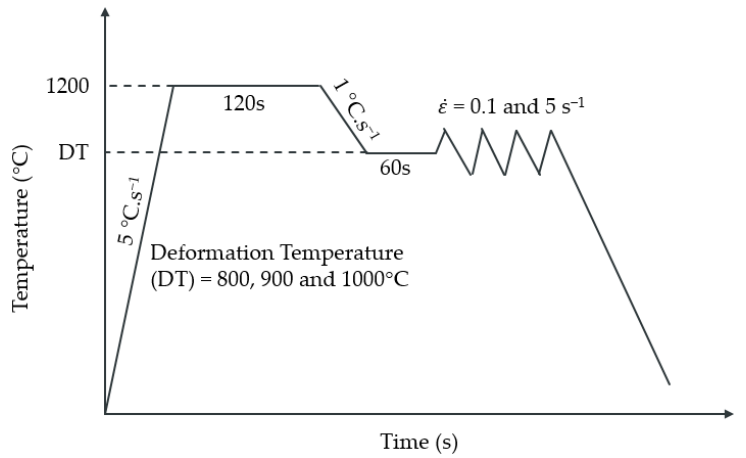
Figure 1. Hot working schedule for testing Fe-Mn-Al-Cr-C-based low-density steels.